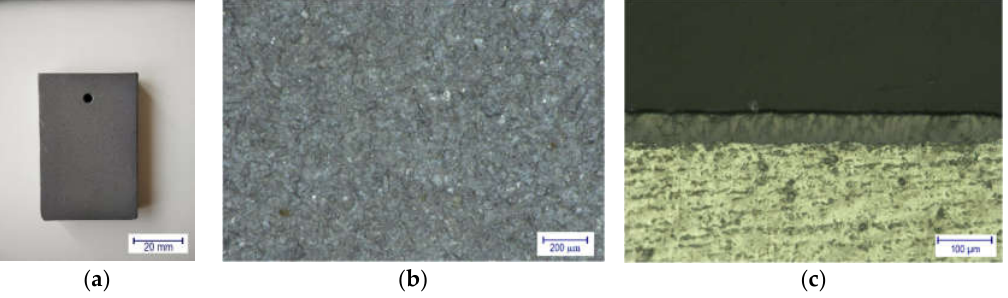
Figure 4. Appearance of an anodized sample at j = 1 A/dm 2 and 1 h, as ( a ) visible, ( b ) under an optical microscope, and ( c ) optical microscope image on the cross-section showing both the layer and sub- strate .